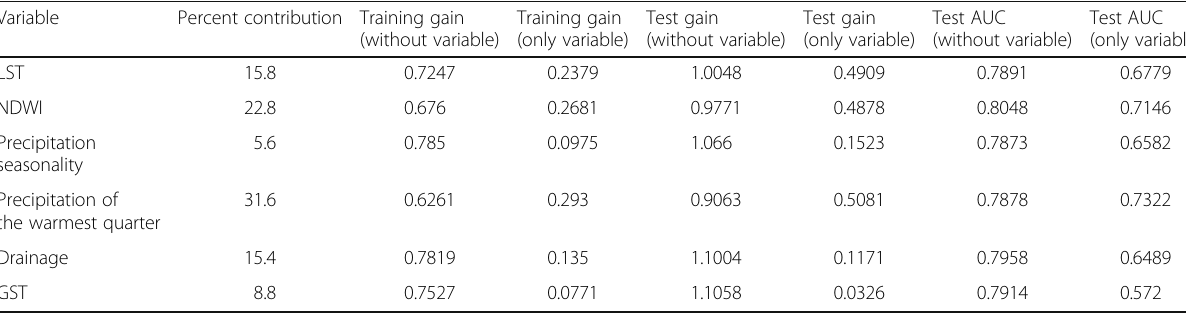
Table 3 Identification of the top three variables based on percent contribution, and training and test gains